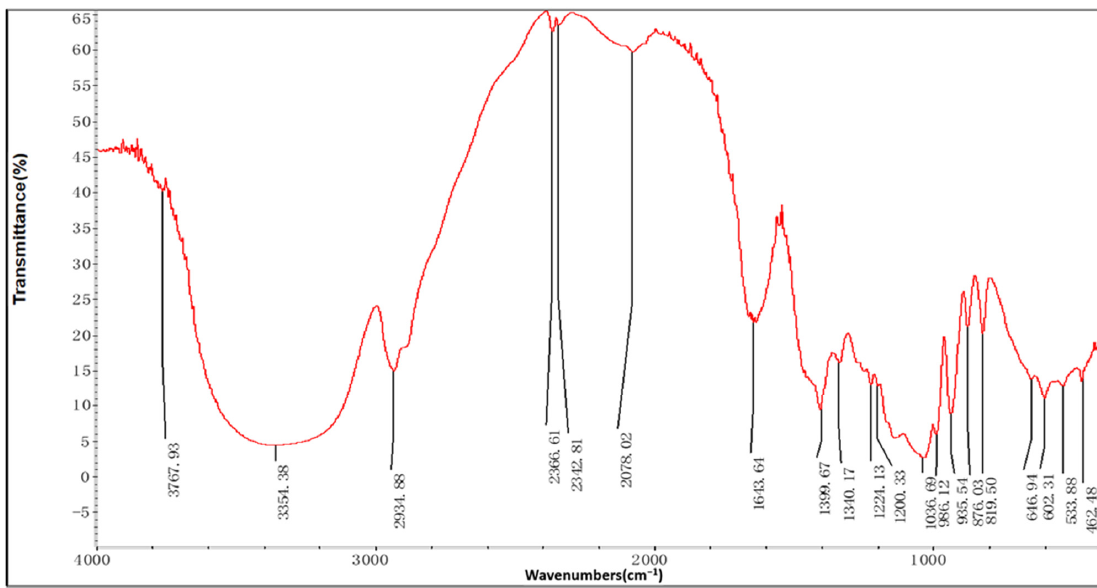
Figure 2. IR spectrum of